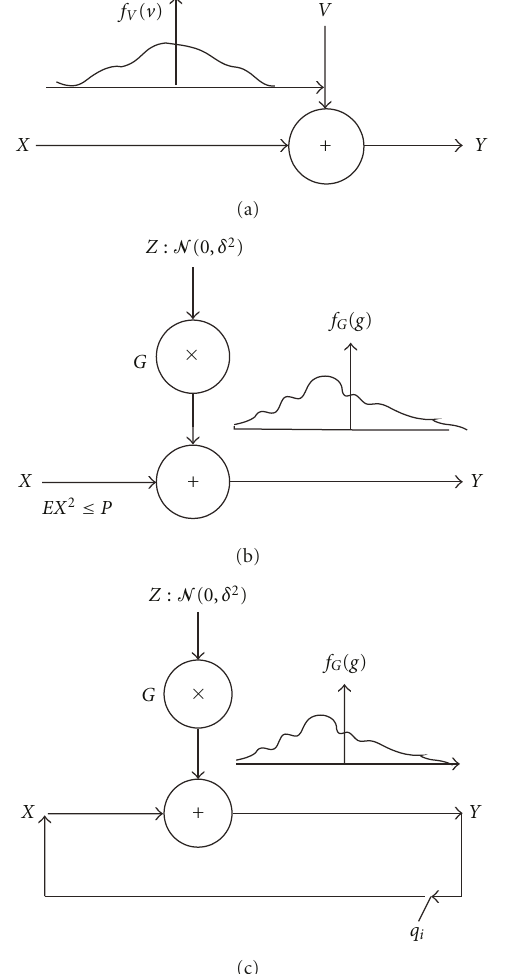
Figure 1: Channel model: (a) original model, (b) new representa- tion of channel model, (c) channel with